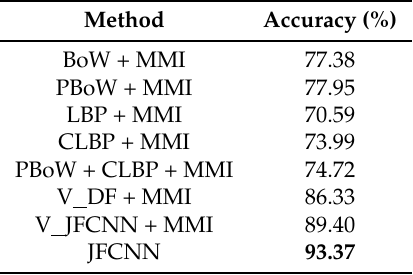
Table 8. Classification accuracies (%) with multimodal